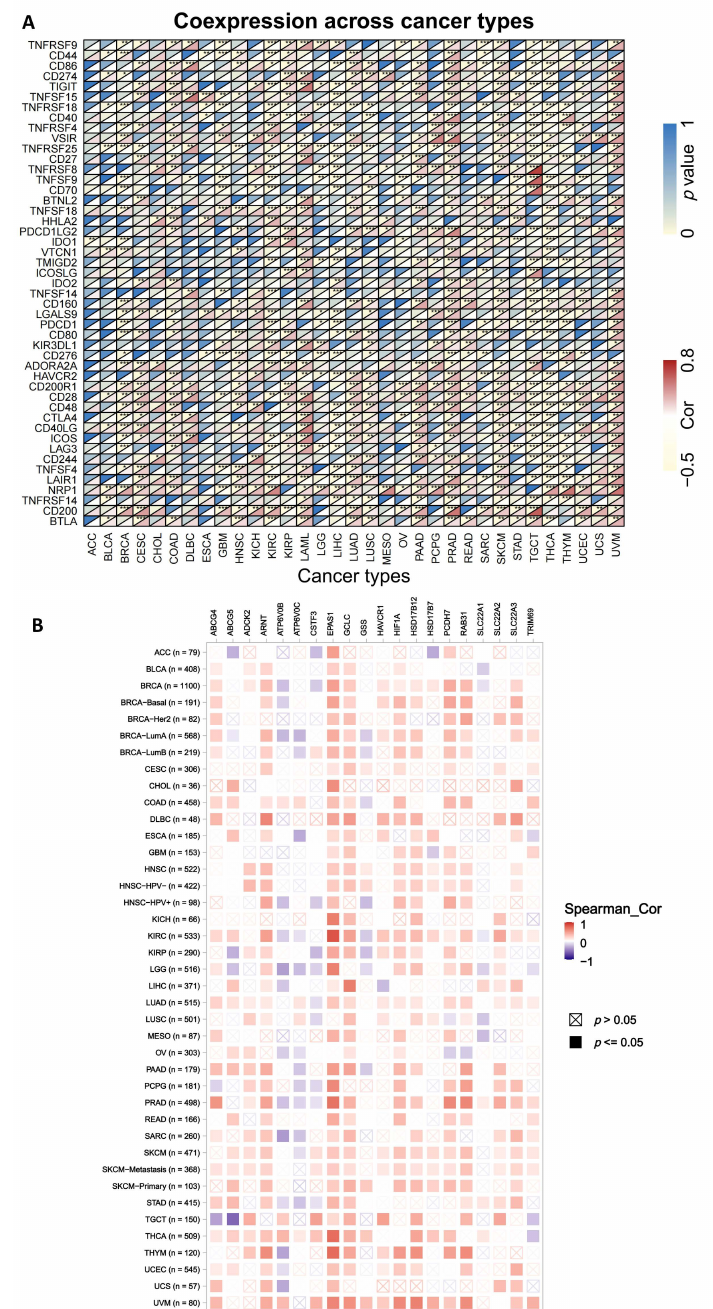
Figure 9. Network of ABCG2-related genes and gene enrichment analysis: ( A ) Co-expression analysis between 47 immune-related genes and ABCG2 gene in the different pan-cancer cohorts of the TCGA database. Upper left corner represents the p -value, and the lower right corner represents the correlation coefficient (* p < 0.05; ** p < 0.01; *** p < 0.001). ( B ) The heatmap shows the expression correlation between ABCG2 and the top 20 ABCG2-related genes analyzed by the TIMER2